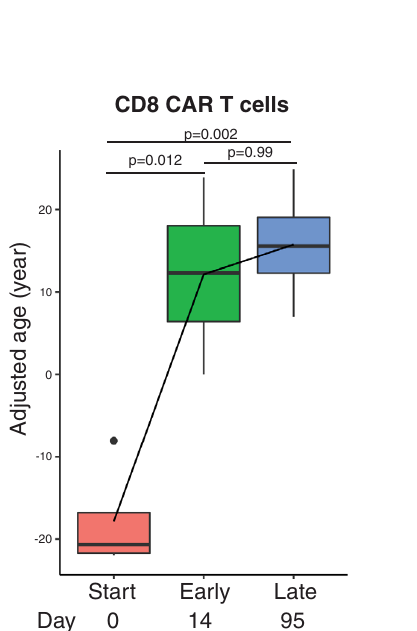
cross validation predicted age of single cells in four major subsets of CD8 + T cells. TrendlineswerefromtheMELRmodelforwhichthetdistributionwithn-2degrees of freedom was used to evaluate if a slope was signi fi cant for a particular variable (2 sided T-test). The line data are in Supplementary Data 6a, b.